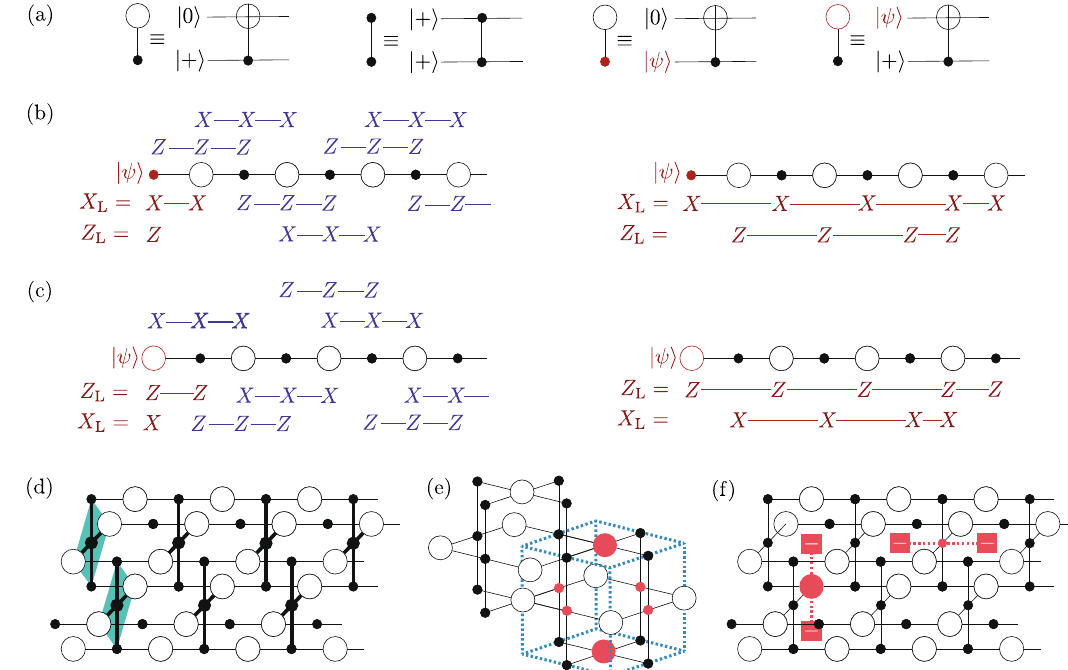
Fig. 3 Our bias-preserving foliation. a Filled black circles denote X -type qubits initialized in the þj i state, open black circles denote Z -type qubits initialized in the 0 j i state, while fi lled/open red circles denote X / Z -type qubits initialized in an arbitrary state. Two X -type qubits connected by a line have a CZ gate applied between them, while an X -type and Z -type qubit connected by a line have a CX gate applied between them as shown. b Left: The logical operators (red) and stabilizers (blue) of the X -start 1D cluster state. Right: By multiplying the logical operators by stabilizers, we can rewrite the logical operators to involve only X operators on the fi rst nX -type qubits and Z operators on the fi rst nZ -type qubits. Measuring the fi rst nX -type qubits in the X basis and the fi rst nZ -type qubits in the Z basis teleports logical information to qubits {2 n + 1, 2 n + 2}. c Same, for Z -start qubits. d By coupling ancilla X -type qubits (bold) to an alternating grid of X -start and Z -start 1D cluster states, we can measure multi-qubit logical operators during teleportation. Here, measuring the X operator on the ancilla qubits measures the XZZX operators of the neighboring qubits. We thus measure the stabilizers of the XZZX code as we teleport. e The unit cell of the resulting cluster state, the bias-preserving XZZX cluster state. One can verify that the product of X operators on the highlighted X -type qubits and Z operators on the highlighted Z -type qubits is a stabilizer of the XZZX cluster state. There is one such stabilizer associated to each cell of the lattice. f A Z error on an X -type qubit or an X error on a Z -type qubit fl ips the stabilizers of the neighboring cells, allowing us to detect errors. Importantly, Z errors create error chains that are restricted to 2D planes, allowing for improved